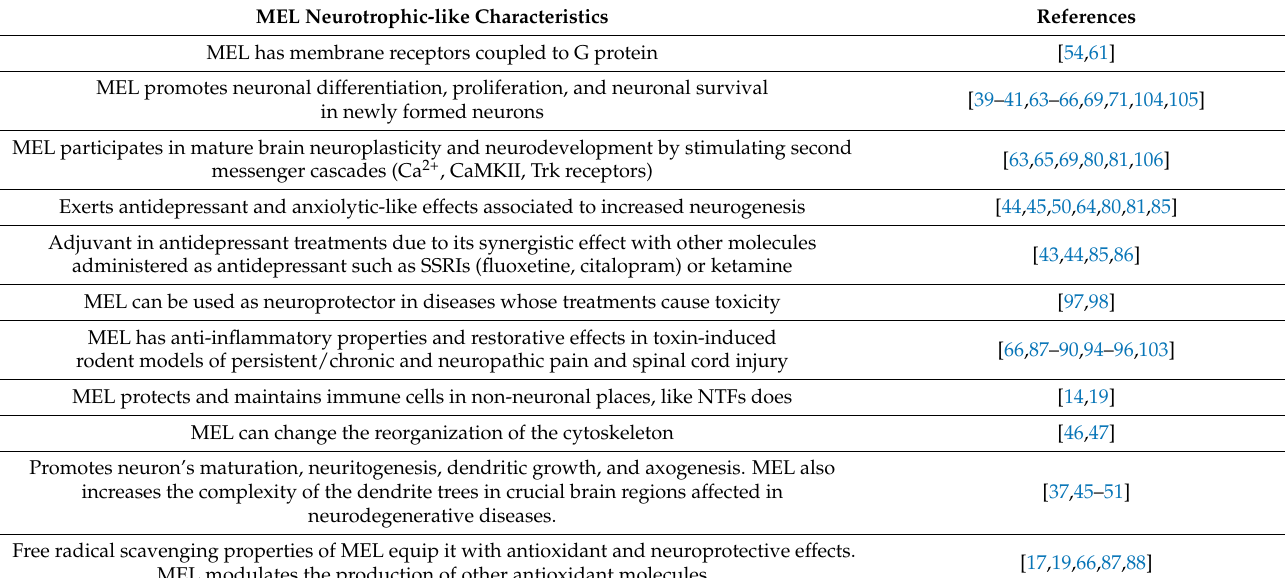
Table 1. MEL effects that support its neurotrophic